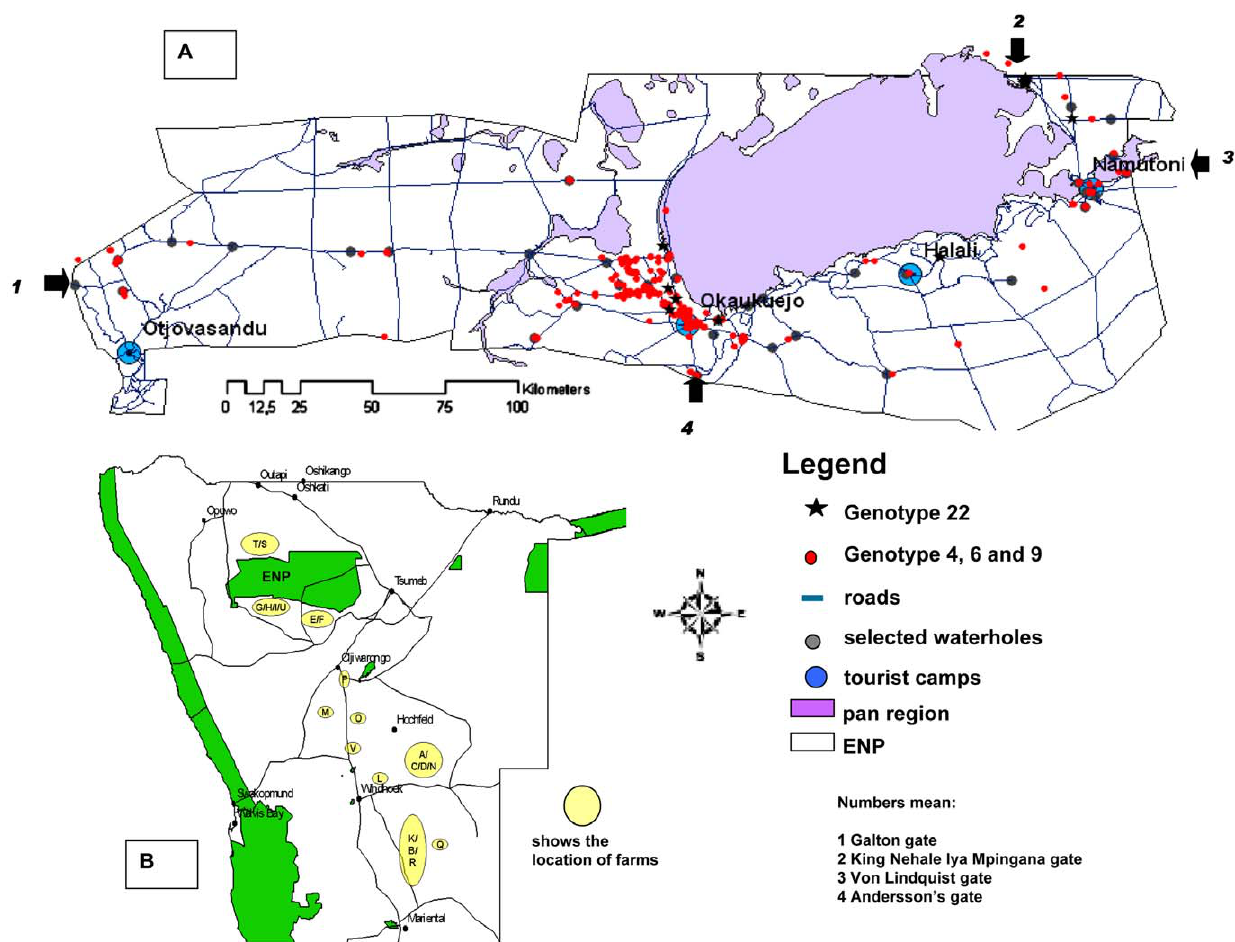
Figure 3. Maps of the Etosha National Park and general location of farms. (A): Main roads, pans, camps and main gates of the ENP are shown. Locations where GTs 4, 6, or 9, and 22 were found are indicated by colored marks. GTs 4, 6, and 9 were given the same label to indicate they are probably the same outbreak strain. Green areas in (B) represent National Park areas.